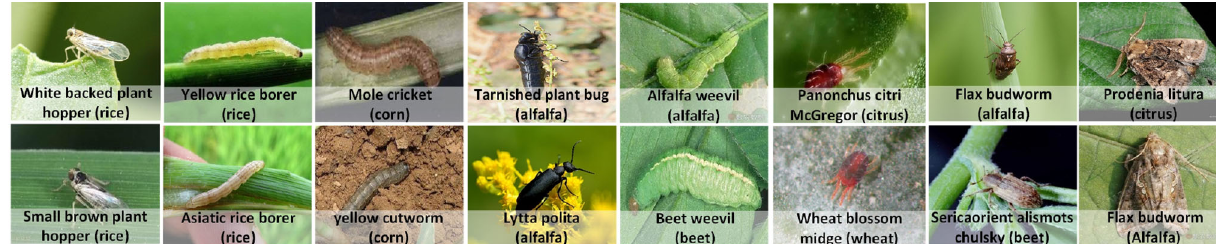
Fig. 7 Sample images of pests species having similar visual features (the label shows the pest-wise class and corresponding crop subclass)